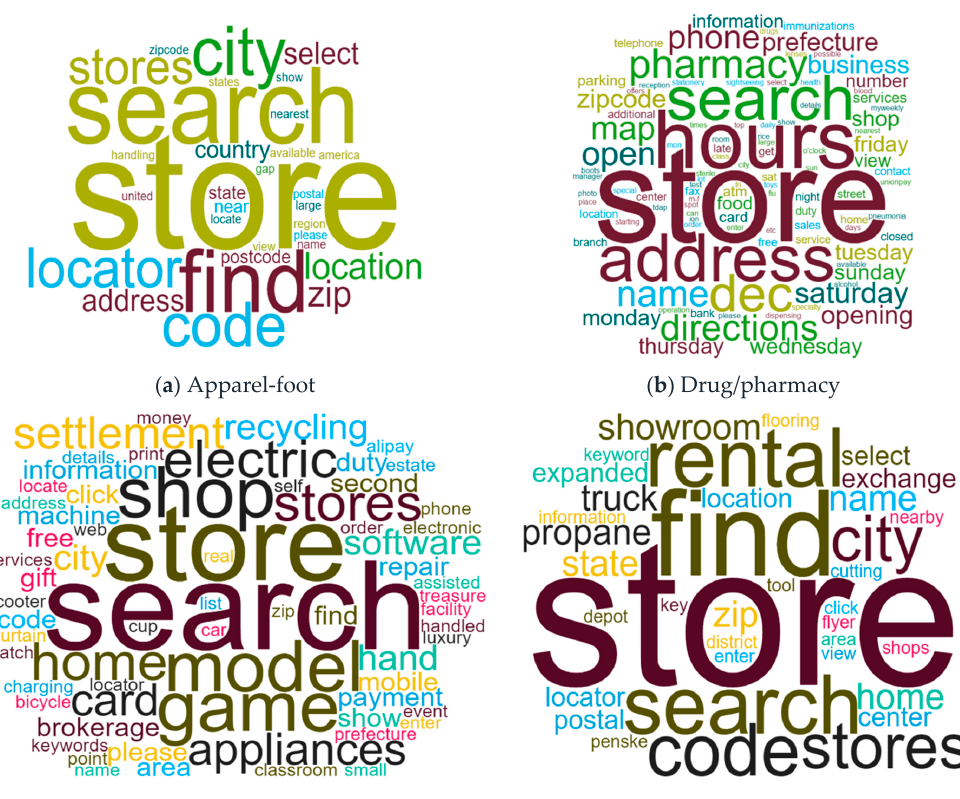
Figure 1. Word clouds on websites of specialty retailers (search tools).